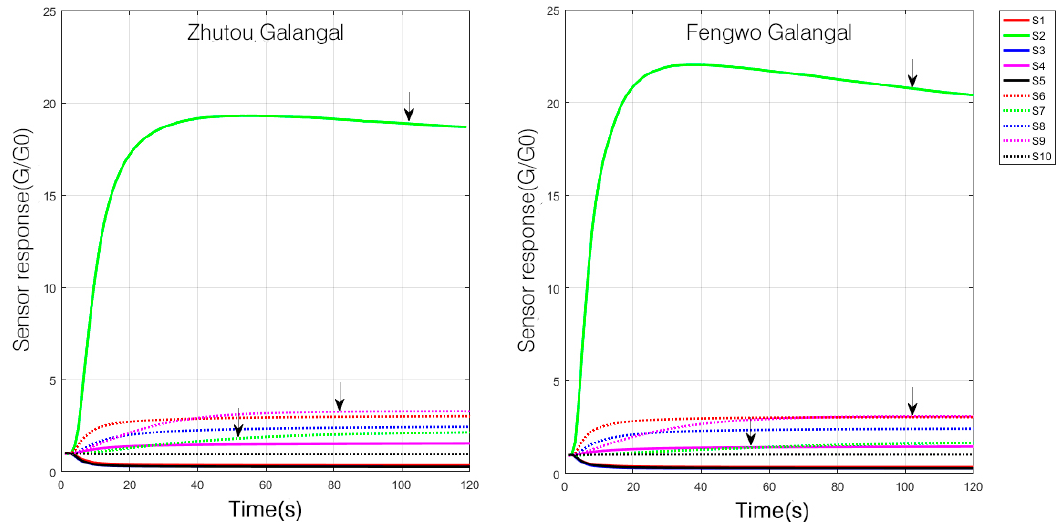
Figure 1. Sensor response of Zhutou galangal and Fengwo galangal.